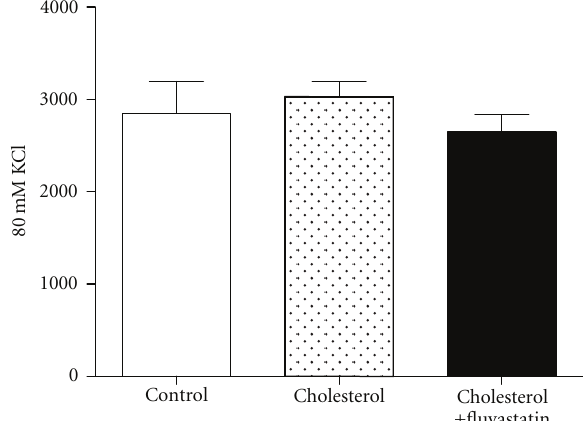
Figure 2: 80mM KCl-induced contractions in carotid arteries from all groups. Data shown in bar graphs are expressed as mean ±